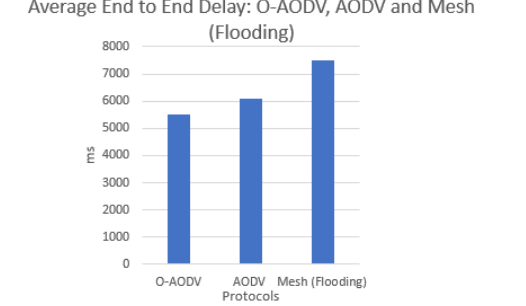
Figure 24. Average end-to-end delay: O-AODV, AODV, and mesh (flooding) comparison.